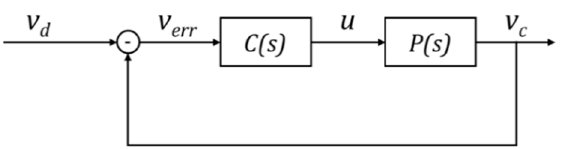
Figure 4. Closed-loop system for the longitudinal velocity control.